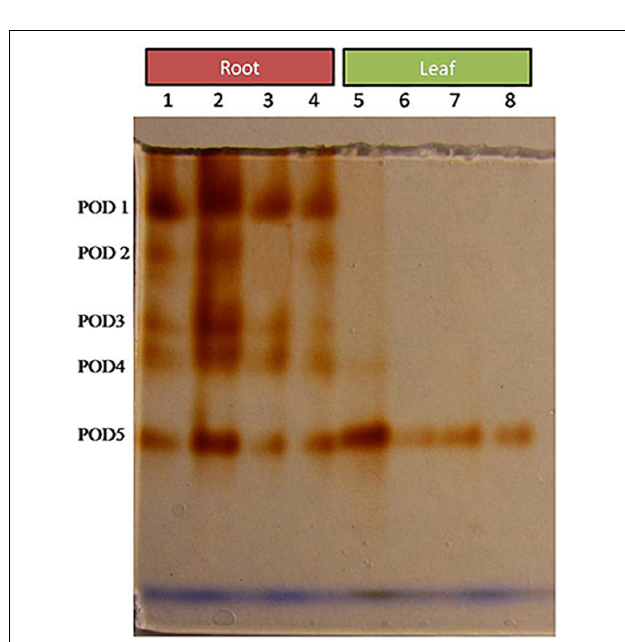
FIGURE 7 | Zymography of POD isoforms expressed in root and leaves upon bacterial (BHU-AV3) inoculation under salt stress. Lanes 1 and 5 – salt treatment; Lanes 2 and 6 – bacterial (BHU-AV3) inoculation + salt; Lanes 3 and 7 – bacterial inoculation; Lanes 5 and 8 – Control. POD 1–5 represents number of isoforms expressed.